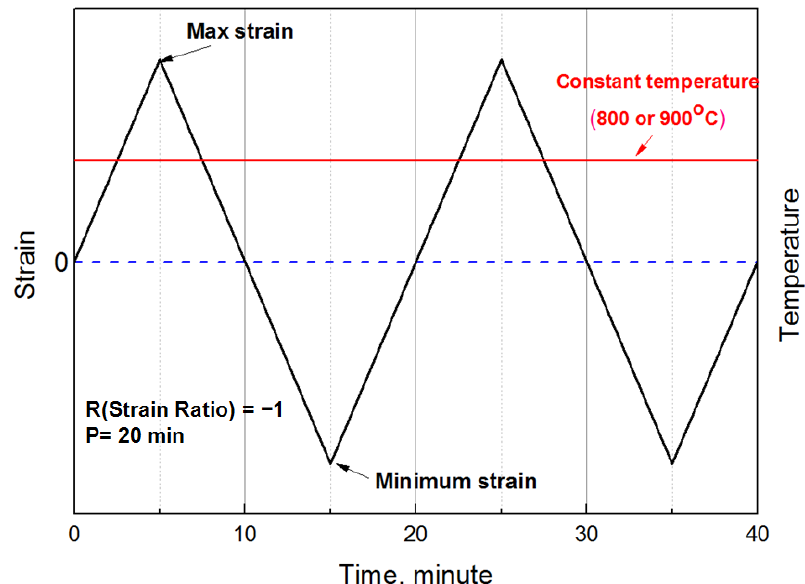
Figure 3. Strain test condition during the low cycle.